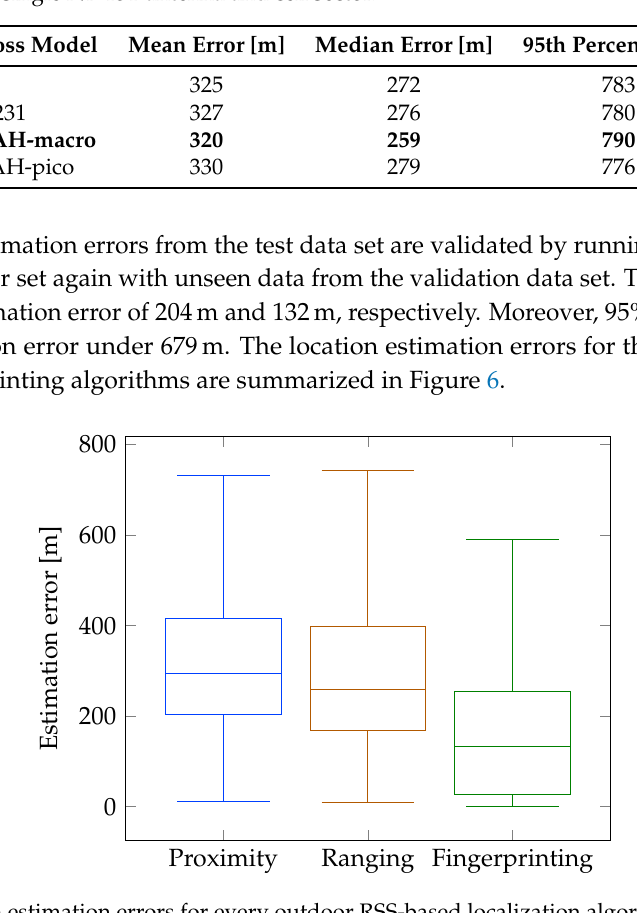
Figure 6. Location estimation errors for every outdoor RSS-based localization algorithm when using a single NB-IoT base station antenna. The left box plot shows the proximity algorithm results. The box plot in the middle shows the errors of the ranging algorithm with the 3GPP AH-maco path loss model. The right box plot shows the estimation errors of the validation fingerprinting data set using the optimal parameter